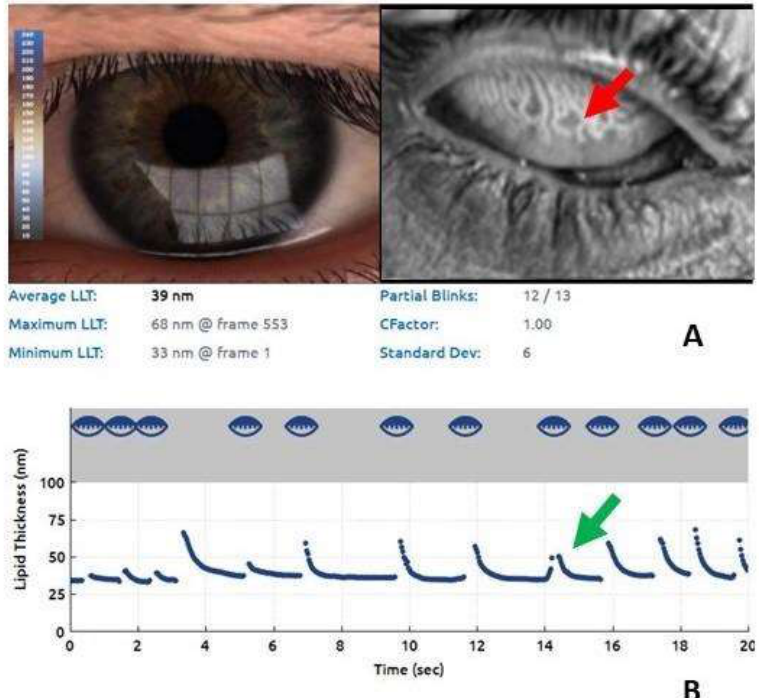
Figure 3. Lipid imaging report and meibography using the Lip iView II (TearScience, Morrisville, NC, USA) ocular surface interferometer. ( A ) Remarkable alterations of the meibomian glands, the dilation of their bodies, the tortuosity of the glandular ducts, and the loss of glandular tissue (blue arrow). ( B ) Significant reduction of the LLT (39 nm) (red arrow). The mean osmolarity of the tear fluid was 328.51 ± 23.8 mOsmol / L. Furthermore, a positive significant correlation was found between the osmolarity and the mRSS (r = 0.79; p < 0.001), showing a marked increase in the subjects with a more serious disease (Figure 4 Graph